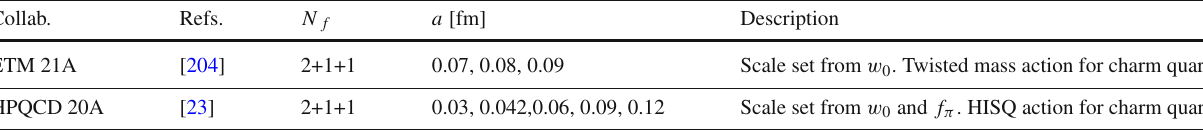
Table 87 Continuum extrapolations/estimation of lattice artifacts in the determinations of m c with N f = 2 + 1 + 1 quark flavours Collab.